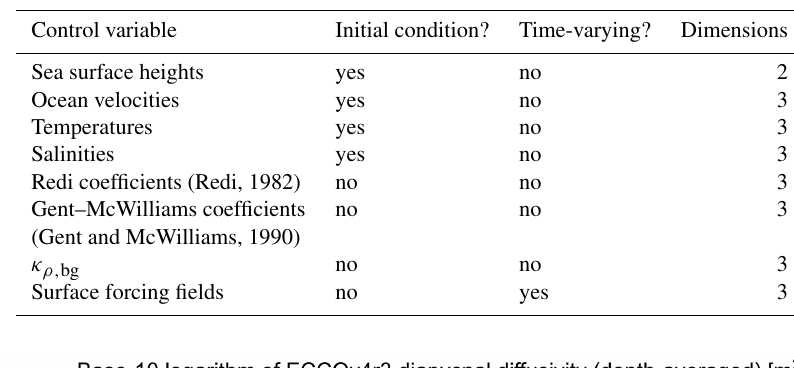
Table 3. The control variables that ECCO inverts for and optimizes. Some of these control variables are initial conditions only (indicated in the “initial condition” column). Other control variables are time-varying (indicated in the “time-varying” column). The rest are not initial conditions but also are time-independent. Also noted is whether the control variable’s field is two-dimensional or three-dimensional – there are no control variables that vary in both time and over all locations and depths of the ocean.